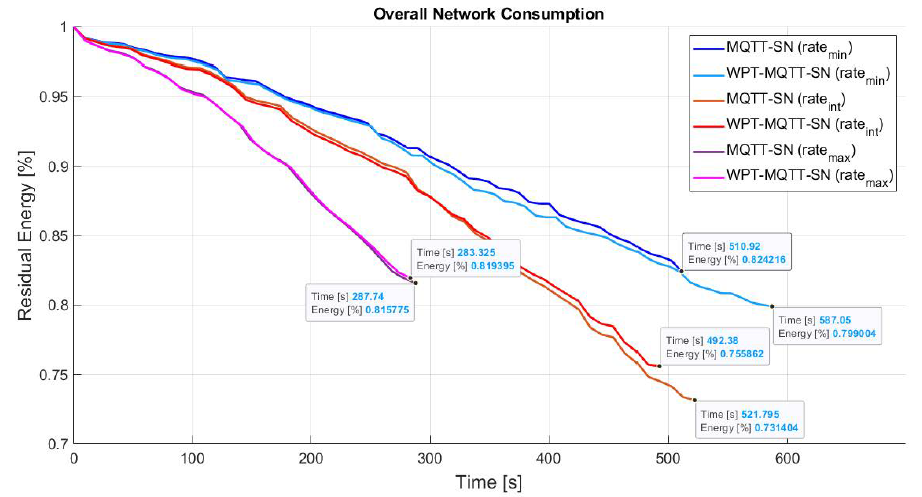
Figure 16. Comparison of WPT for different Publishing rates in Unbalanced Random Mesh